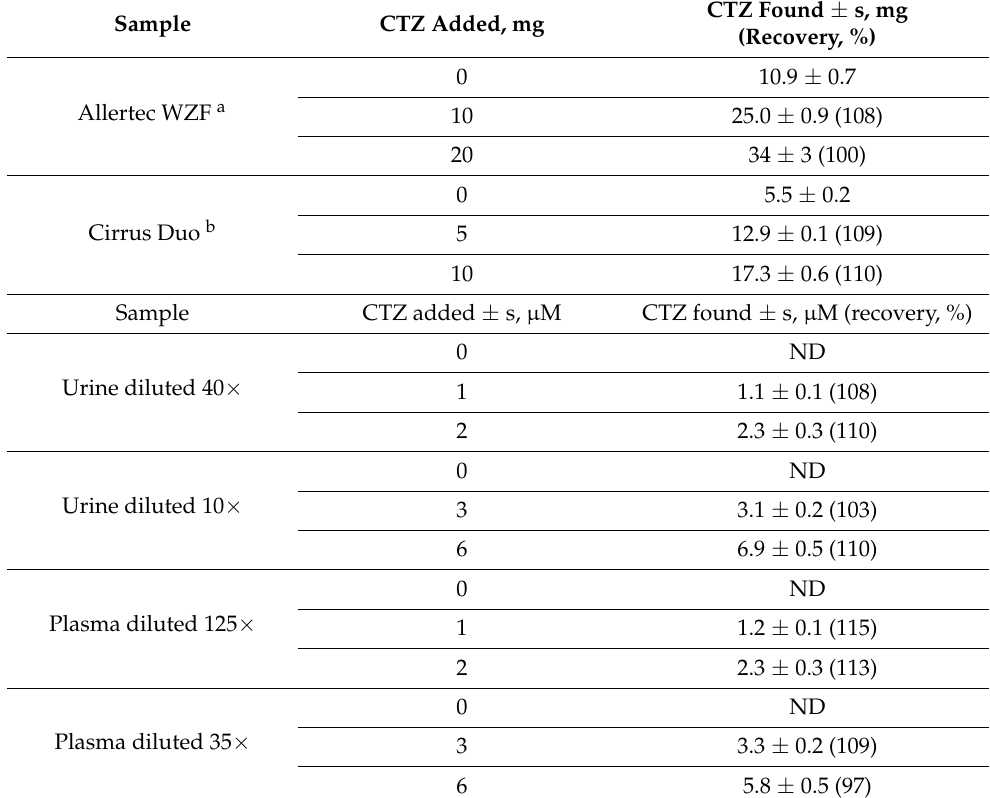
Table 2. Results of sample measurements: tablets and